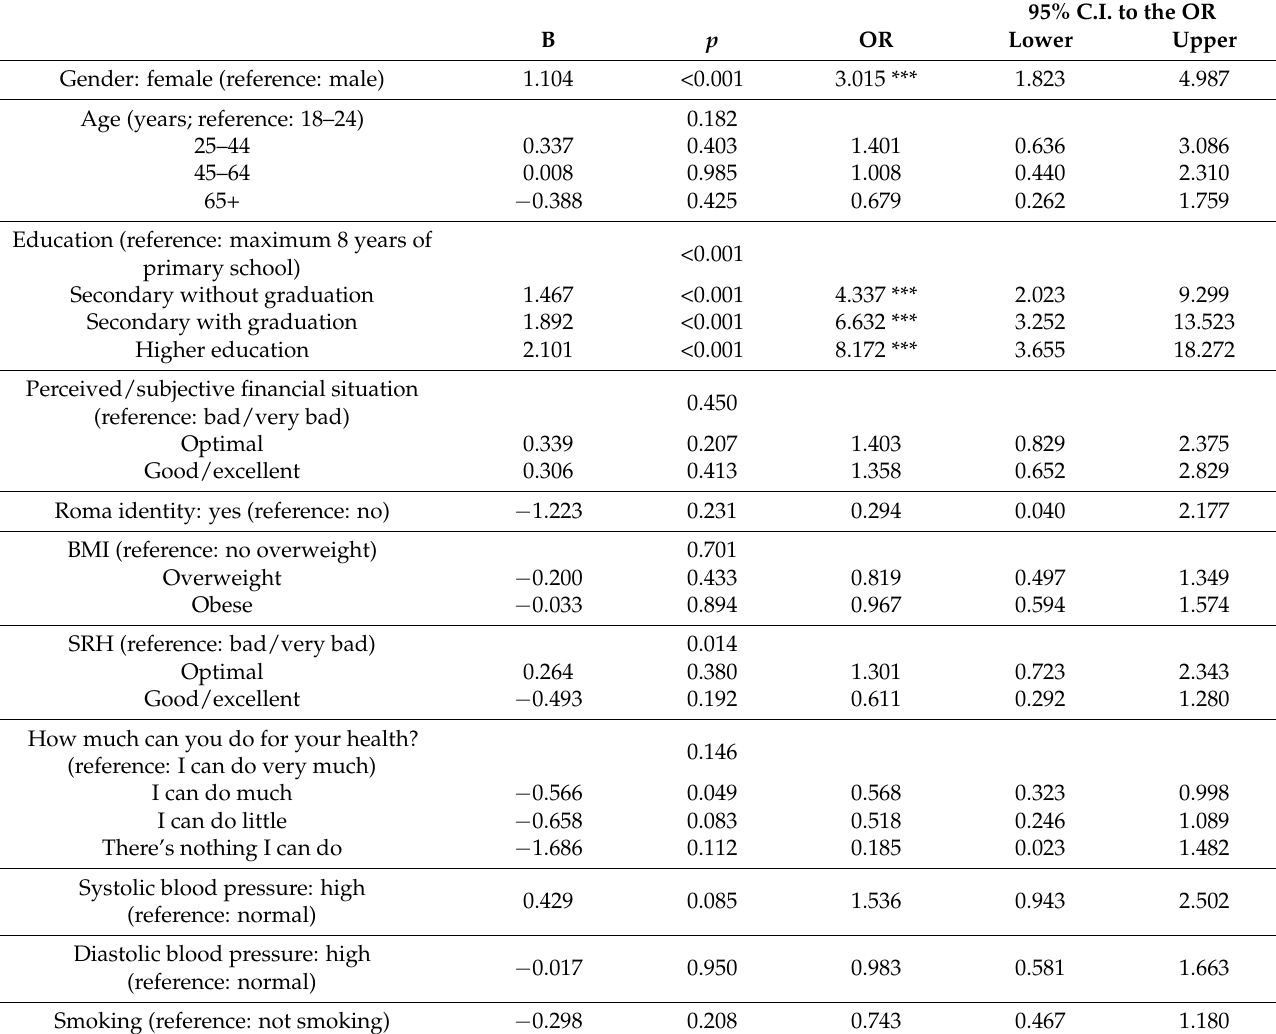
Table 1. Predictors of the receipt of health psychology services through the model program.